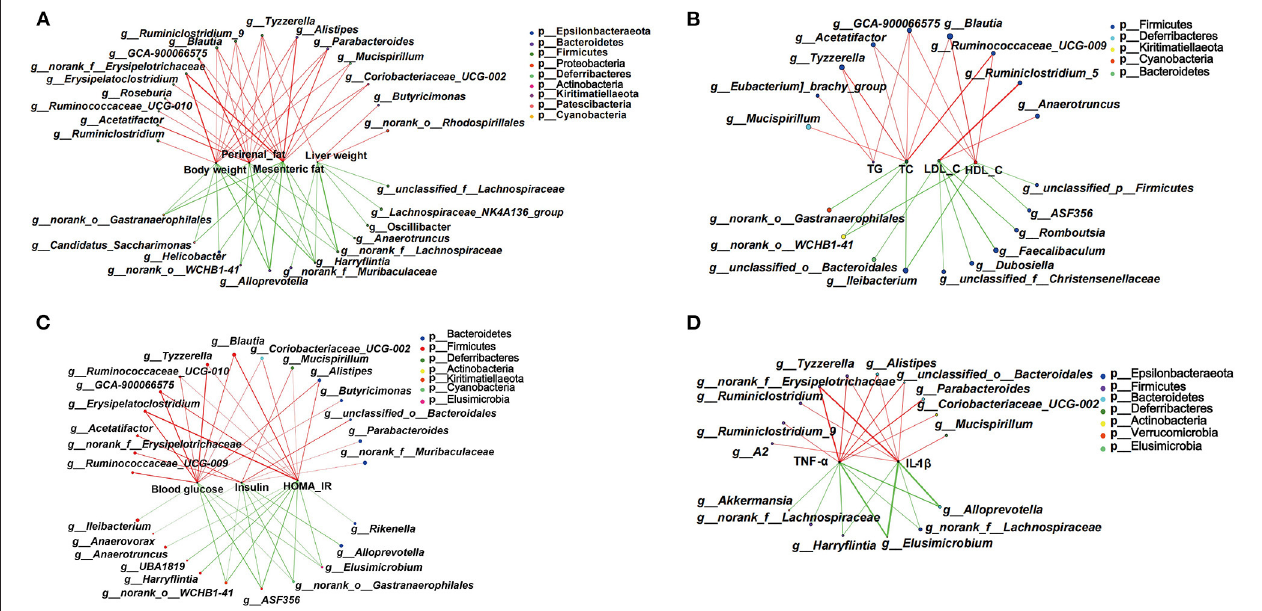
FIGURE 8 | Two-factor correlation network analysis showing correlations between specific gut microbiota and obesity-related biomarkers ( n = 8 mice/group). (A) Correlations between gut bacteria and weight parameters, including body weight, mesenteric fat, perirenal fat, and liver weight. (B) Correlation between gut bacteria and blood lipid profile of TG, T-CHO, LDL-C, and HDL-C in serum. (C) Correlations between gut bacteria and glucose hemostasis, including fasting blood glucose, insulin, and the HOMA-IR index. (D) Correlations between gut bacteria and pro-inflammatory cytokines including TNF- α and IL-1 β in serum. Spearman’s r coefficient, |r| of ≥ 0.5, p < 0.05. Red lines represent r ≥ 0.5, and green lines represent r ≤ −